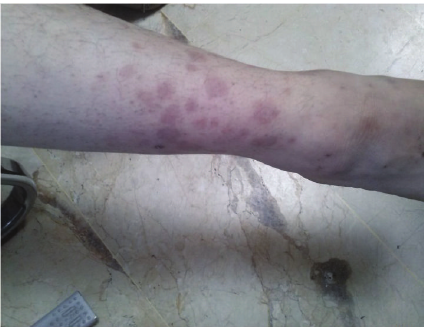
Figure 1: Nonblanchable maculopapular eruptions on the anterior parts of tibias.